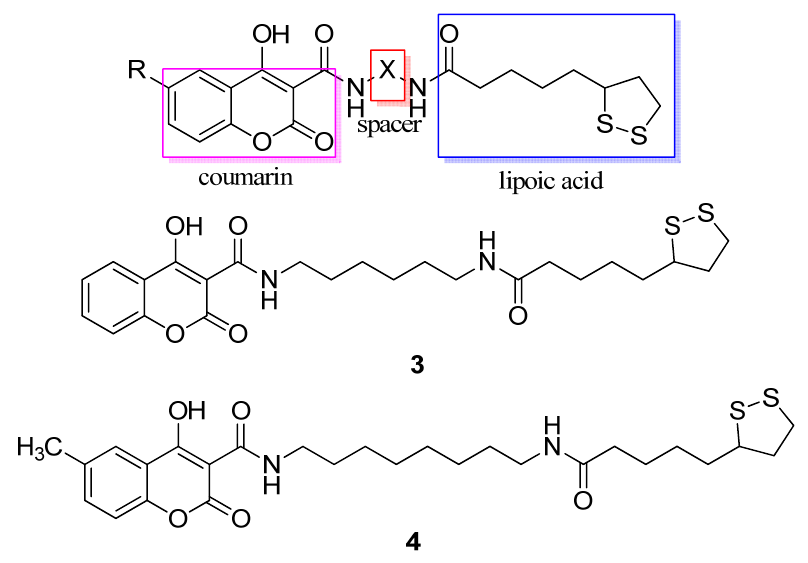
Figure 10. Hybrid of coumarin/lipoic